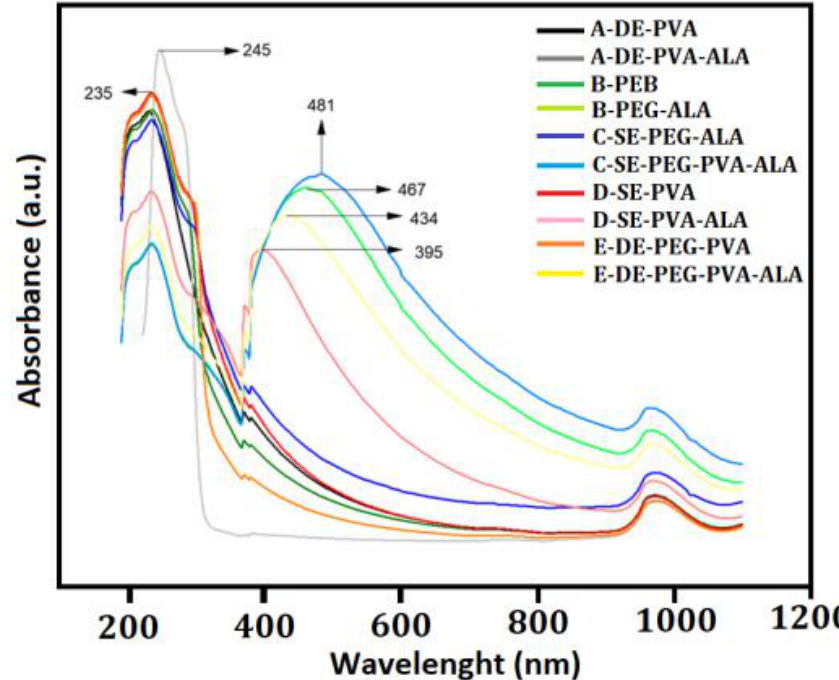
Figure 3. UV-VIS spectroscopy of the unloaded and loaded systems.